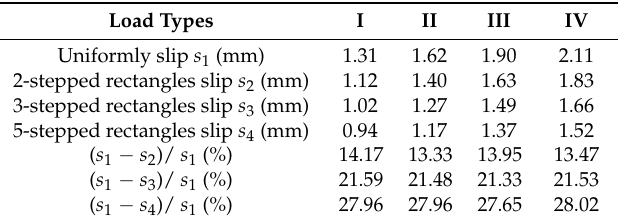
Figure 9. Distribution of stiffness for every type of stepped rectangle. Table 4. Comparison of beam end interface slip under four load cases.